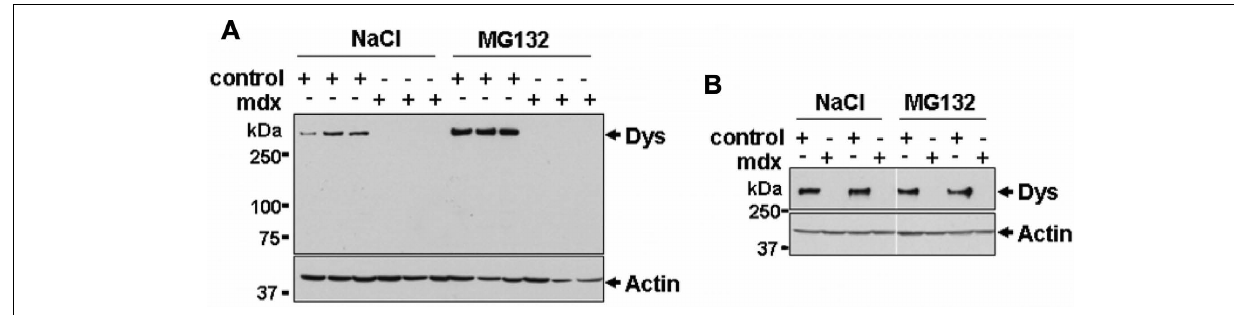
FIGURE 3 | Dystrophin is not expressed in skeletal muscle and in cardiomyocytes of mdx 5cv mice treated with MG132. Western blots of mouse ventricular myocytes (A) and gastrocnemius muscle (B) lysates of control and mdx 5cv mice treated with MG132 or 0.9% NaCl, as indicated.